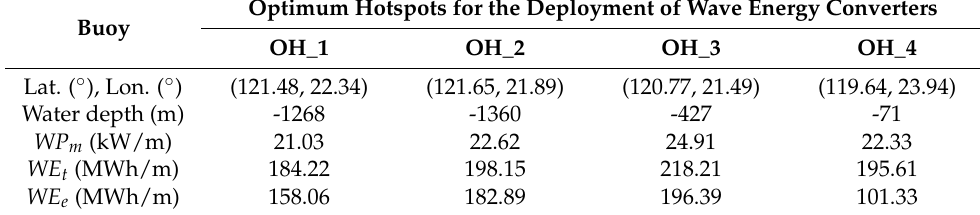
Table 4. Characteristics of the selected optimal wave energy hotspots.